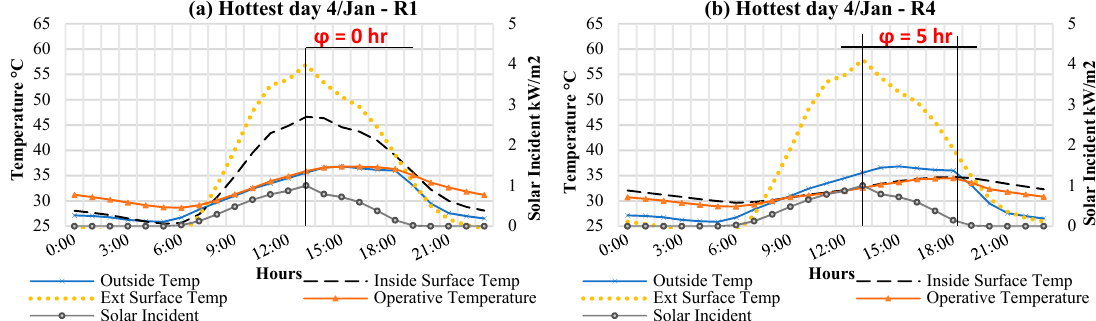
Figure 6. Annual Energy requirement ( a ) and heat gains ( b ) for different roof configurations.